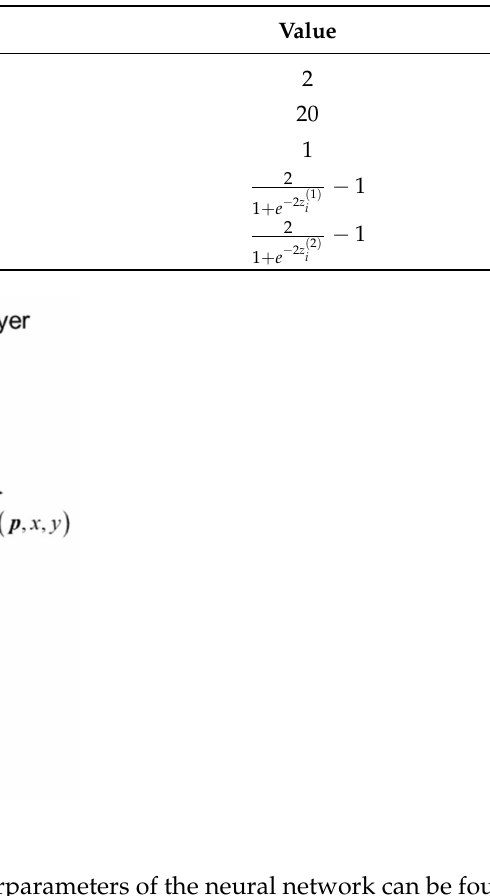
Table 3. Parameters of the FNN structure.